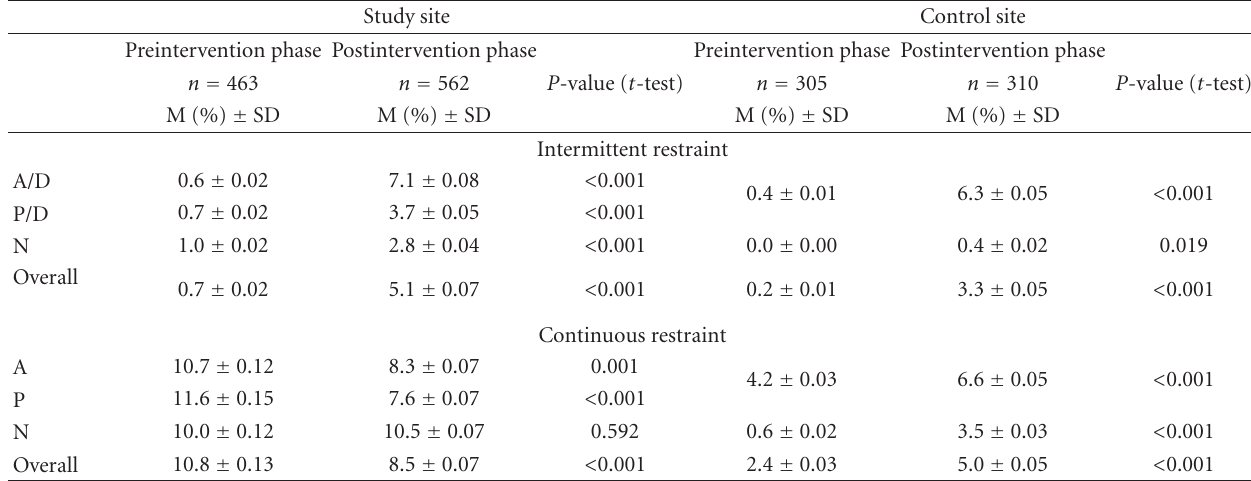
Table 3: Comparison of the pre- and postintervention restraint rates in the study and control sites. Study site Control